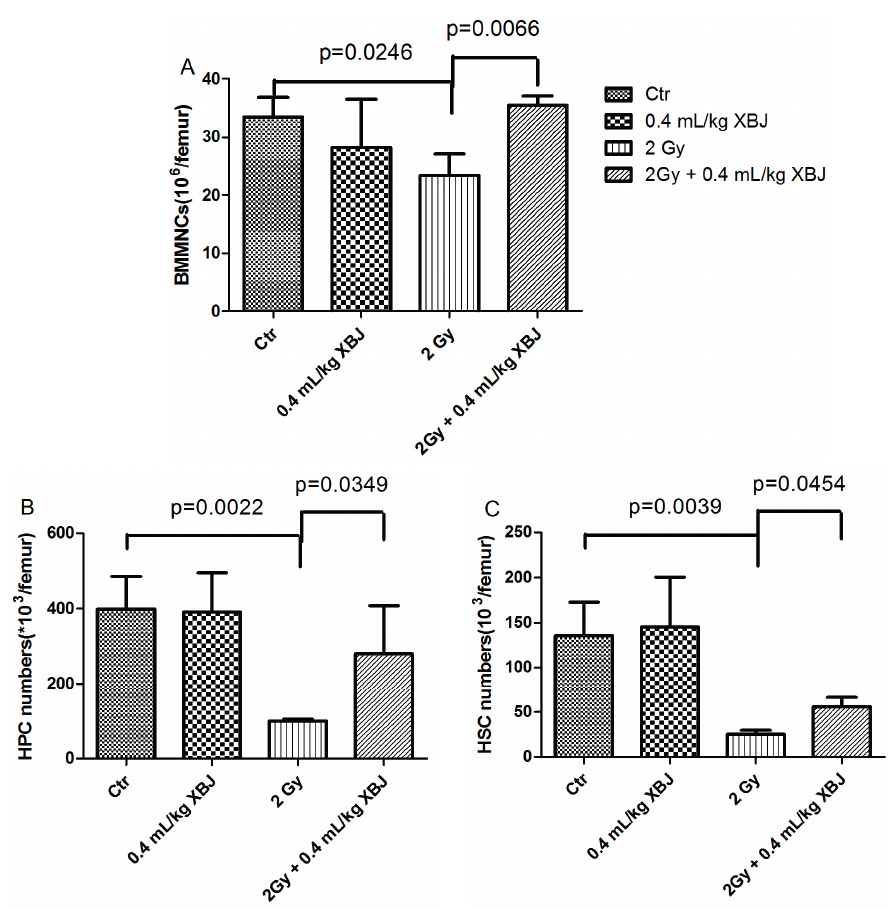
Figure 2. The effects of XBJ on the number of BMMNCs, hematopoietic progenitor cells (HPCs) and hematopoietic stem cells (HSCs) in irradiated mice. Mice were treated with i.p. injection of the vehicle or XBJ after exposure to 2 Gy TBI, as described in the experimental section. A group of sham-irradiated mice was included as a control (Ctr) and received XBJ. BMMNCs ( A ) were counted after the mice were euthanized nine days post-radiation. The number of HPCs ( B ) and HSCs ( C ) was calculated using the formula: BMMNCs per femur × the HPC or HSC ratios detected by flow cytometry. The data are expressed as the means ±